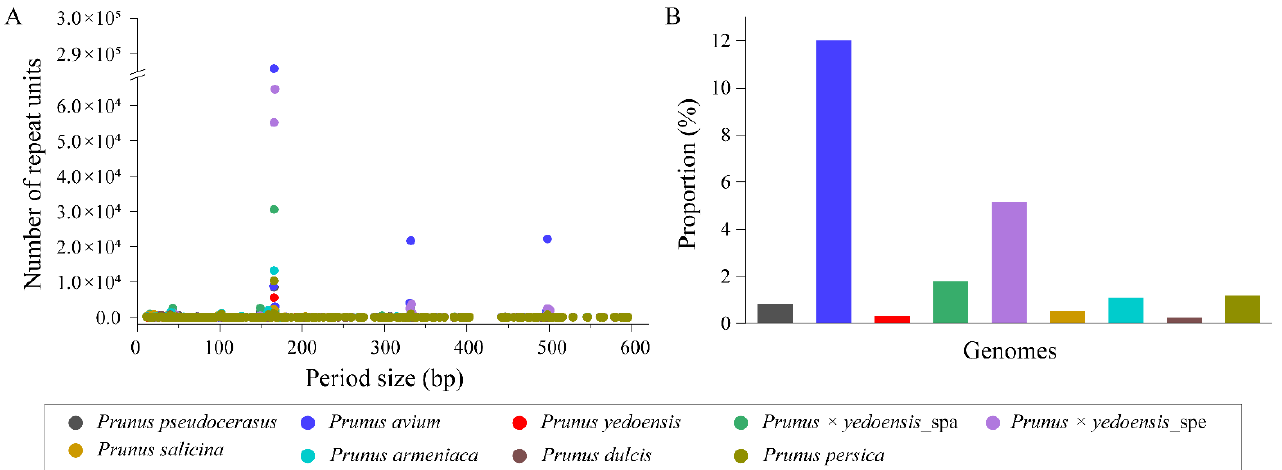
Figure 3. Analyses of TR sequences in nine haploid genomes of eight taxa. ( A ) Length distribution of TRs in the genomes; ( B ) TR contents in the genomes.